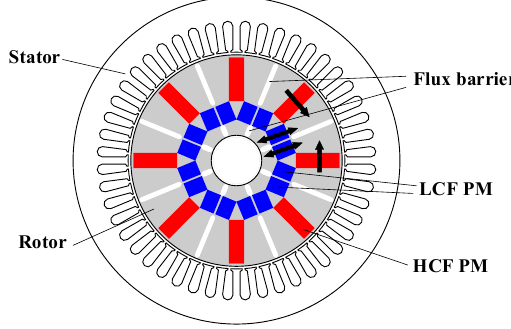
Figure 25. U ‐ type parallel hybrid PM VFM machine [73].